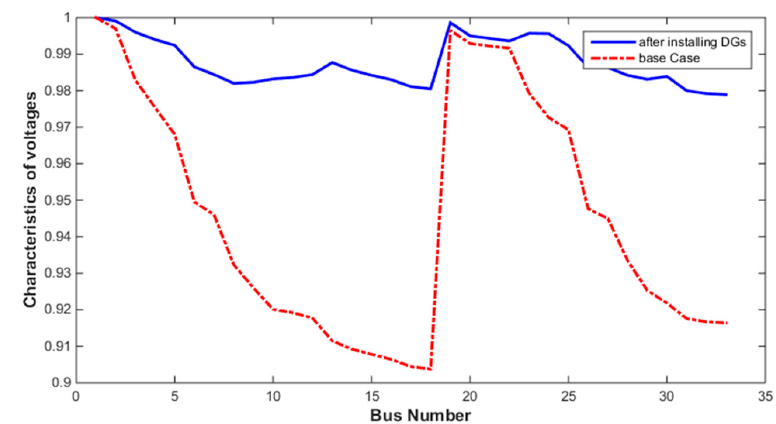
Figure 9. Characteristics of voltage at unity pf.